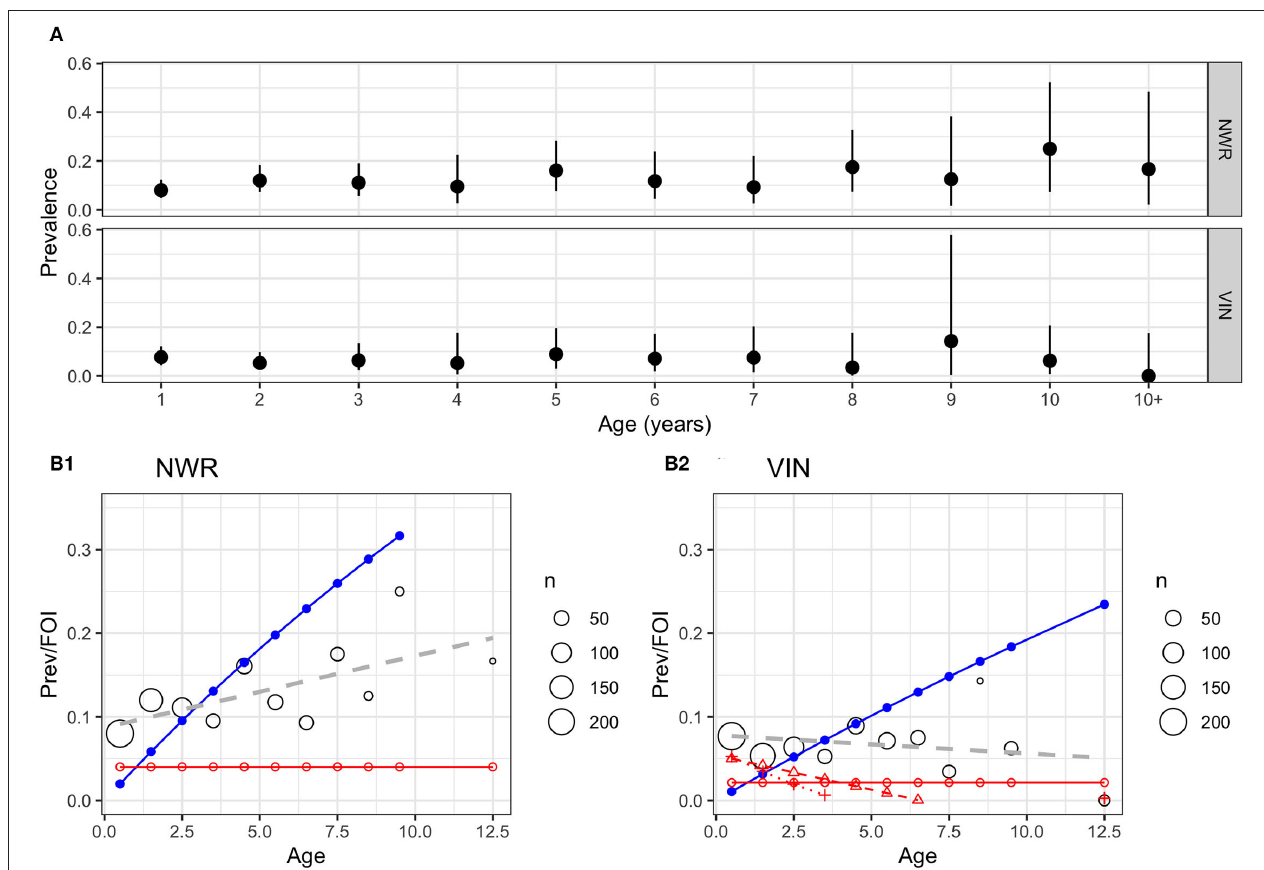
FIGURE 4 | (A) Age-stratified IFN- γ positivity prevalence by age (years) with unadjusted 95% CI for the two pastoralist cattle keeping sites in NWR and VIN. (B1,B2) Age-stratified prevalence of IFN- γ positivity prevalence in cattle in two sites in Cameroon in 2013. The predicted prevalence based on a simple linear age function (blue line) and a constant force of infection ( λ ) (red line) based on the Muench model. The black circles show the mean prevalence for that age strata with the size proportional to the number of animals in that age strata and a simple linear regression model of IFN- γ positivity with age in years (gray dashed line).